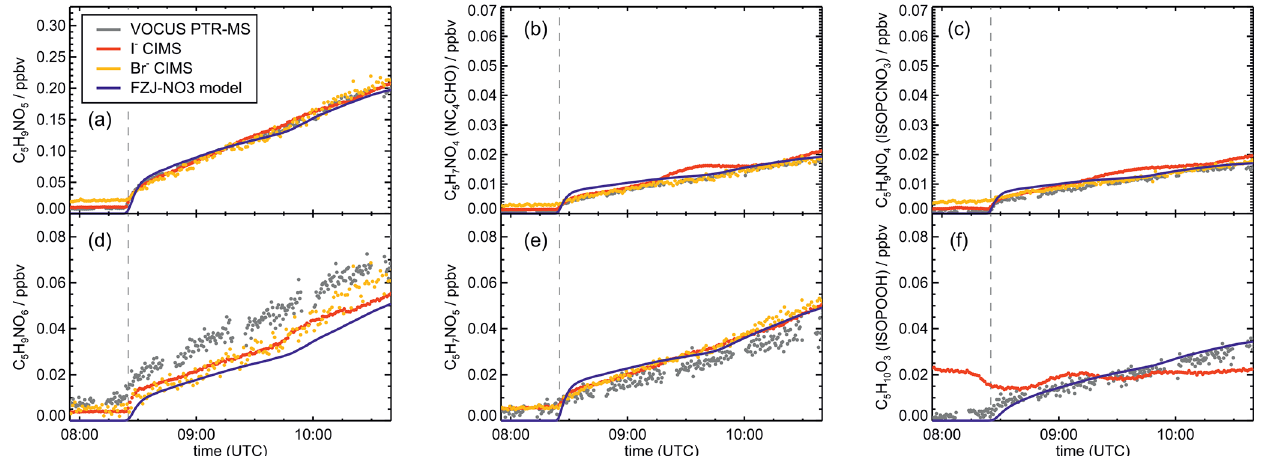
Figure A8. Comparison of reported signals from three mass spectrometer instruments applying different ionization methods (Vocus PTR- MS, Br − CIMS, I − CIMS) and measuring organic products in the experiment on 10 August 2018 (Experiment 2). All signals are scaled to match best the concentrations resulting from model calculations applying the FZJ-NO3 chemical mechanism.